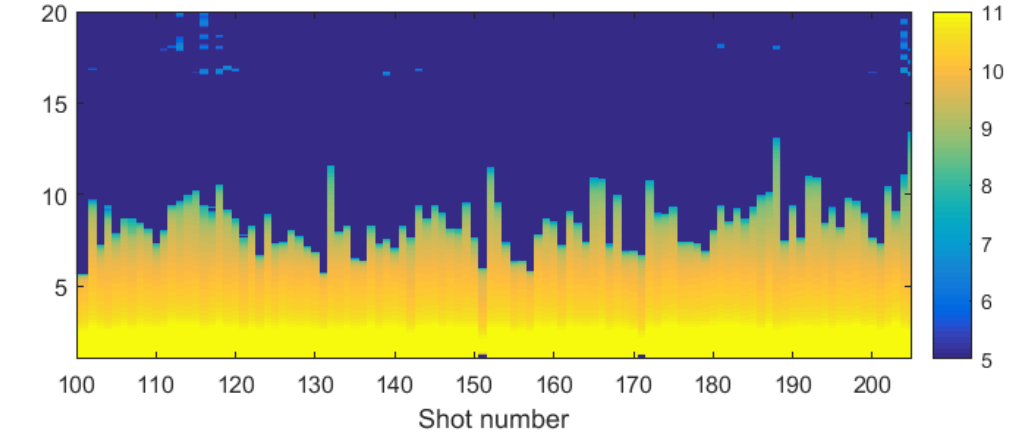
Figure 23. Processed data for a high repetition-rate (0.5 Hz) series of 100 shots on 12 μm aluminum target. The plot provides the proton energy distributions online in terms of particle flux (color bar) and cutoff energy for each shot in the series.